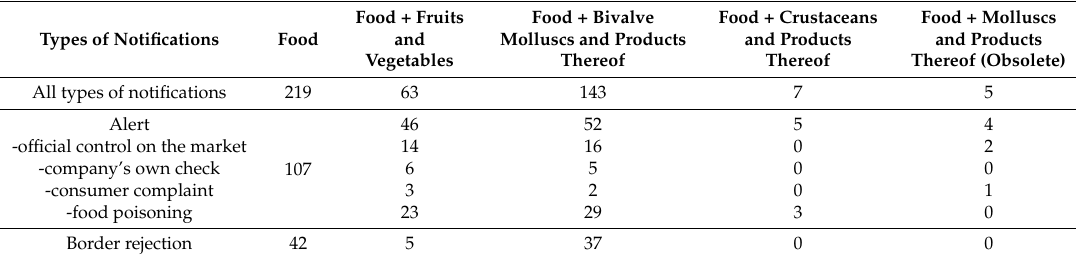
Table 1. Alert and border rejection notifications * for “norovirus” in food generally, and in the implicated food product categories from 1979 until 31 August 2017 in the European Union Rapid Alert System for Food and Feed (EU RASFF)